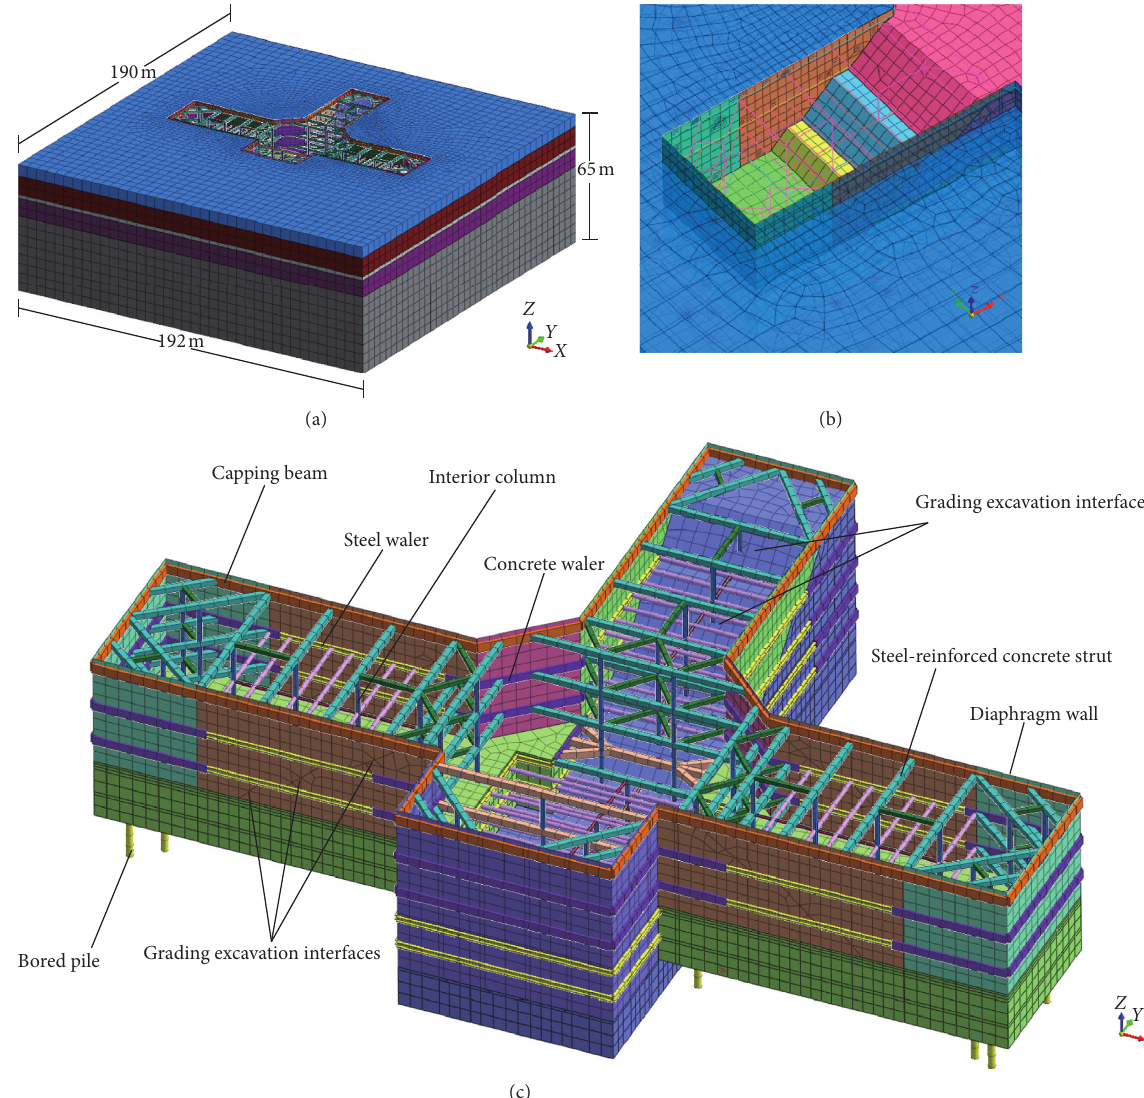
Table 5: The parameters of the pile and the wall.